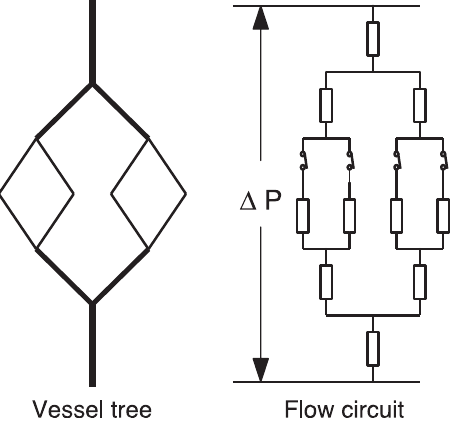
Figure 3. A vessel network and the corresponding electrical circuit. There is a switch at the inlet of each capillary group in the middle layer.